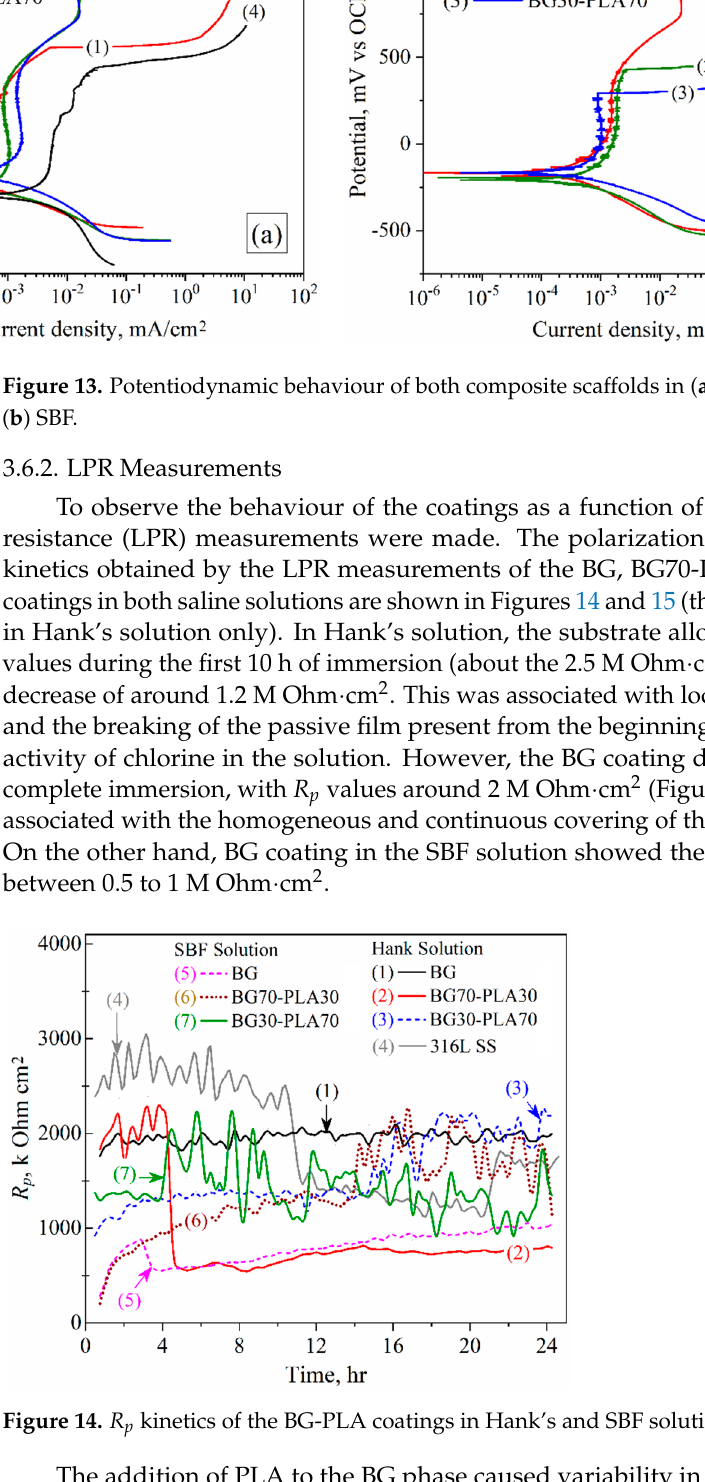
Figure 14. R p kinetics of the BG-PLA coatings in Hank’s and SBF solutions at 37 °C.